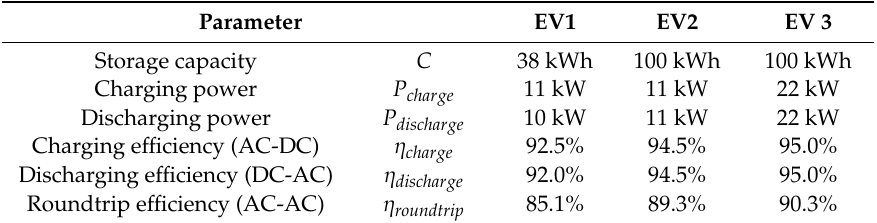
Table 1. List of relevant electric vehicle (EV) parameters and chosen set of parameter